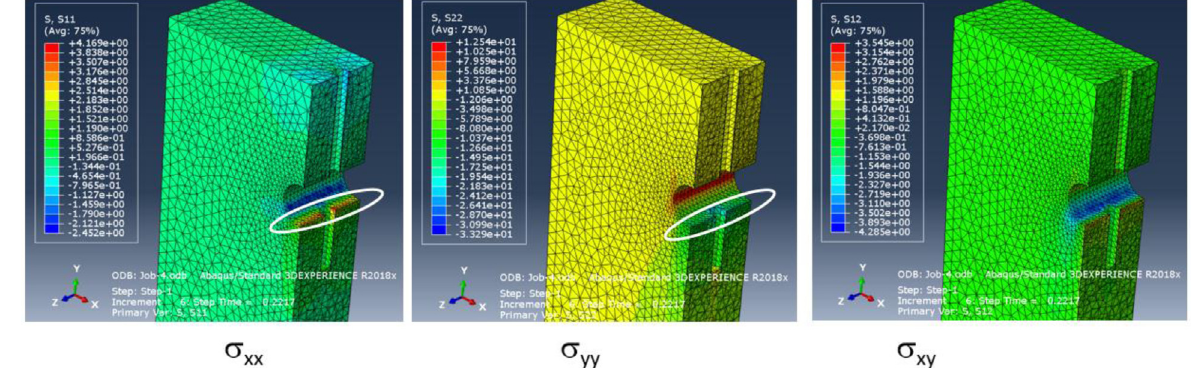
Fig. 18. Stresses s xx , s yy and s xy in the wooden part of the assembly.